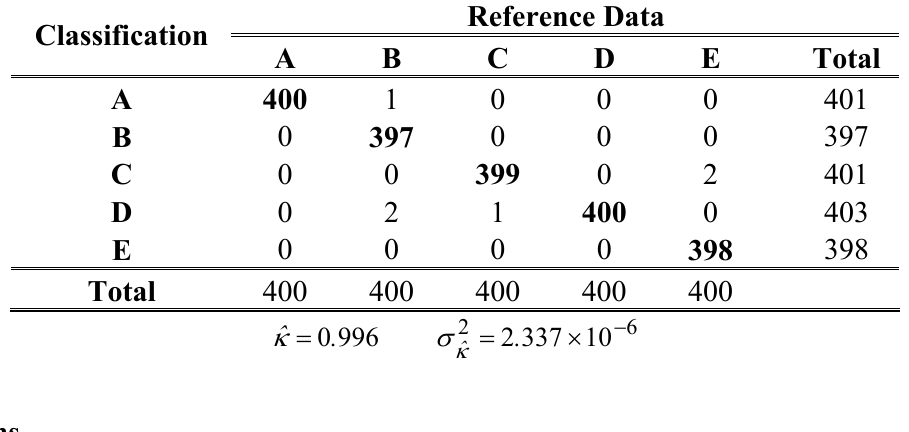
Table 11 . Confusion matrix (# of pixels) using the Gaussian bivariate distribution for PDR - PDS